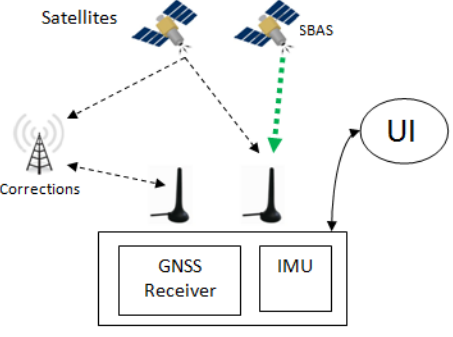
Figure 2: Concept of the LARA